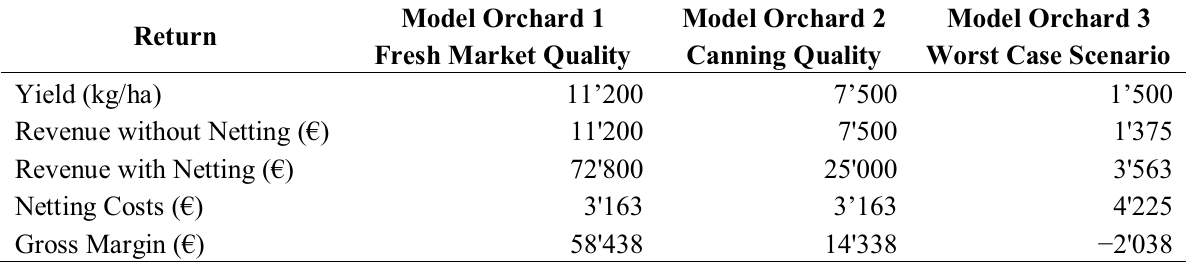
Table 1. Gross return (cid:11)(cid:188)(cid:12)(cid:3) on the installation of netting in Swiss organic cherry orchards (see materials and methods for assumptions used for the